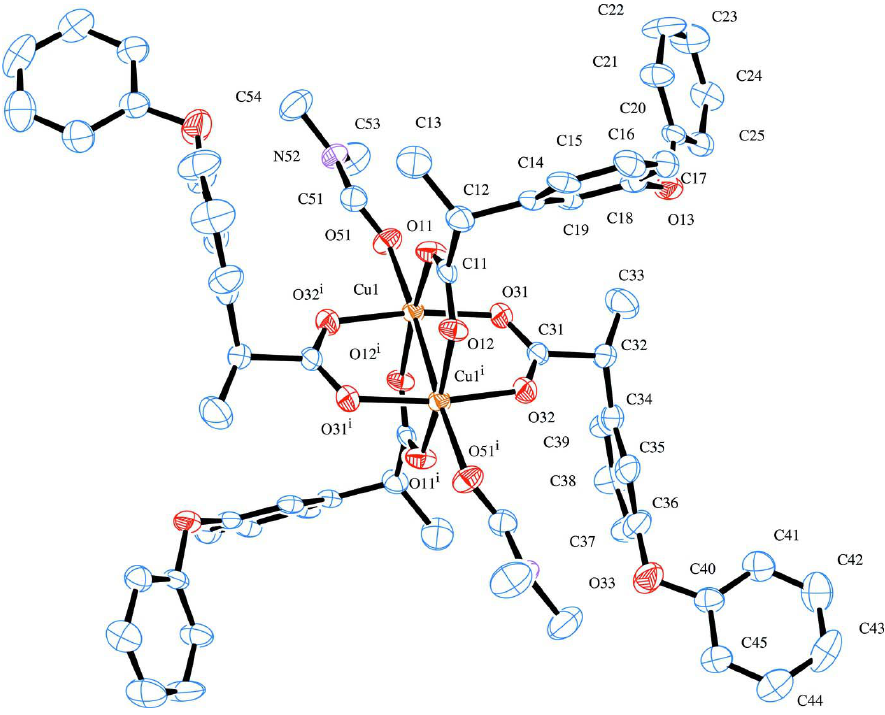
Figure 1 The structure of the Cu the 30% probability level. Hydrogen atoms have been omitted for